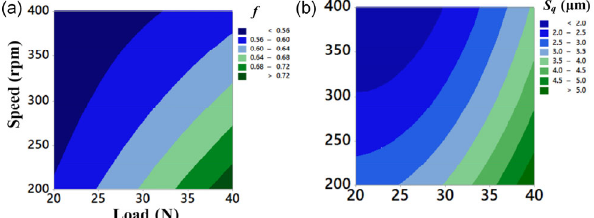
Fig. 21 Response surface plots of (a) friction coefficient (f), S = 0.027, R -sq = 93.81%, α = 0.05, R -sq (adj.) = 83.49 %, (b) RMS roughness ( S q ), S = 0.4, R -sq = 96.17%, α = 0.05, R -sq (adj.) = 56.71 %.